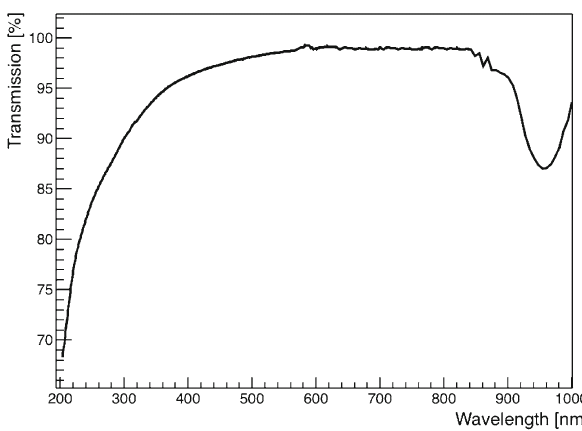
Fig. 9 Relative transmittance of collimating lens/fiber vacuum feedthough and 200 μ m fiber leading to the